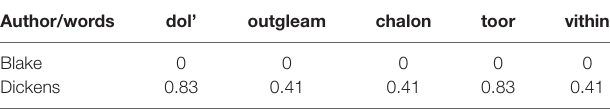
Table 2 | Top five distinctive words (stems) with usage rates (1/1,000) in Blake’s and Dickens’ poems of the GEPC.